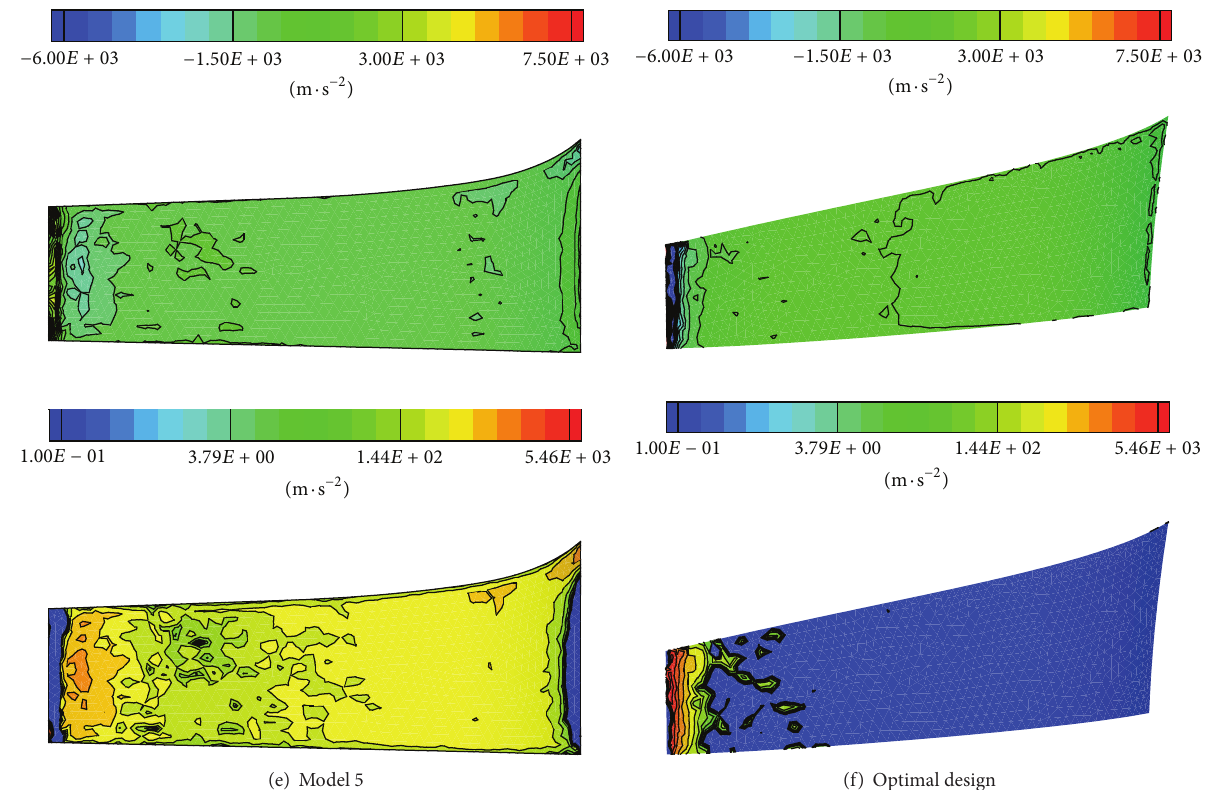
Figure 13: BVF 𝑧 distribution on blade’s pressure